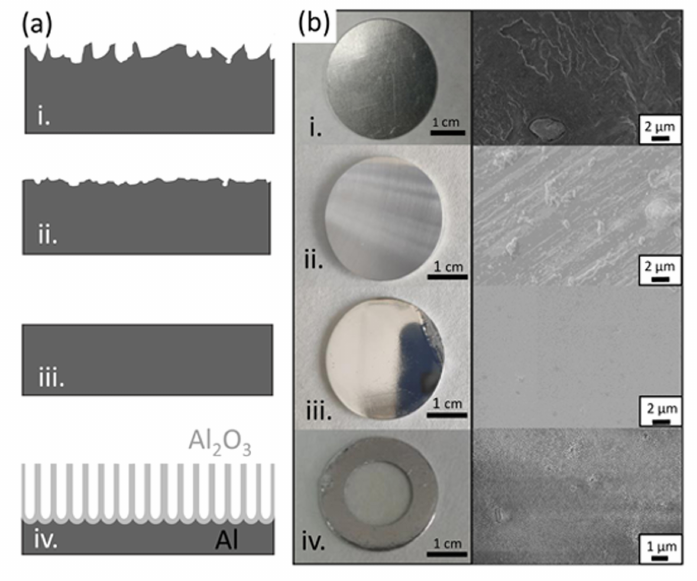
Figure 1. ( a ) Schematics of the cross-section of the aluminum samples during the alumina template preparation: (i) starting material, (ii) after mechanical polishing, (iii) after electrochemical polishing and (iv) after the anodization process and Al etching. ( b ) shows the surface morphology optical images ( left ) and scanning electron micrographs ( right